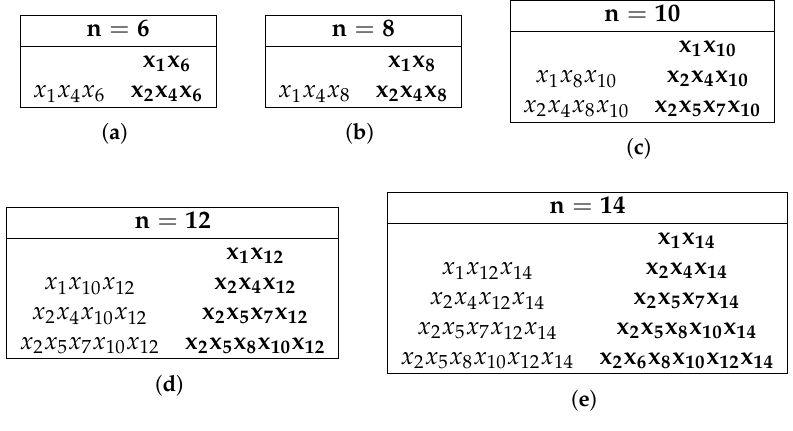
Figure 2. Monomial generators for n = 6 ( a ) , 8 ( b ) , 10 ( c ) , 12 ( d ) , 14 ( e )